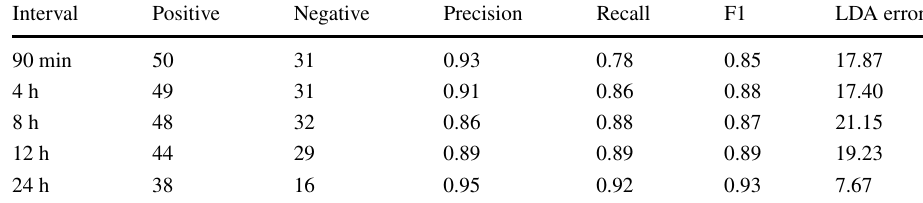
Table 6 The results: all criterion satisfied